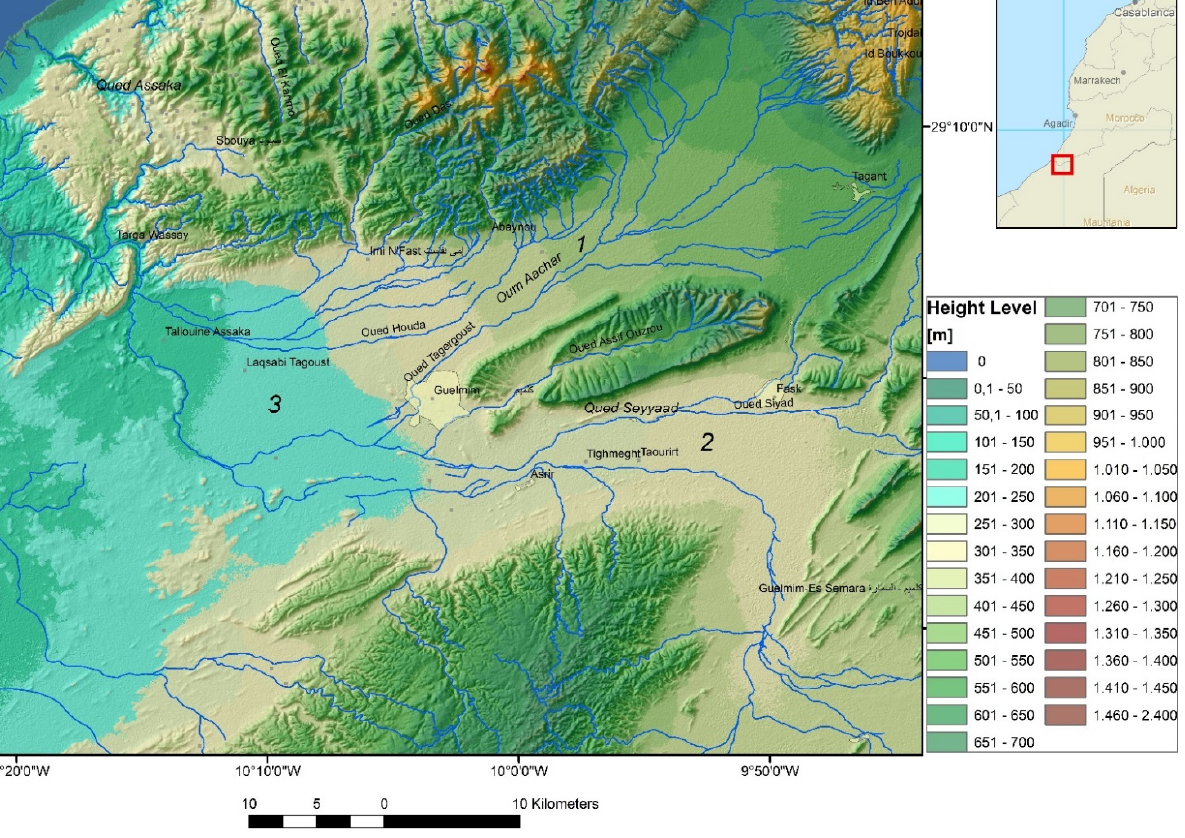
Figure 3. Height level map based on SRTM